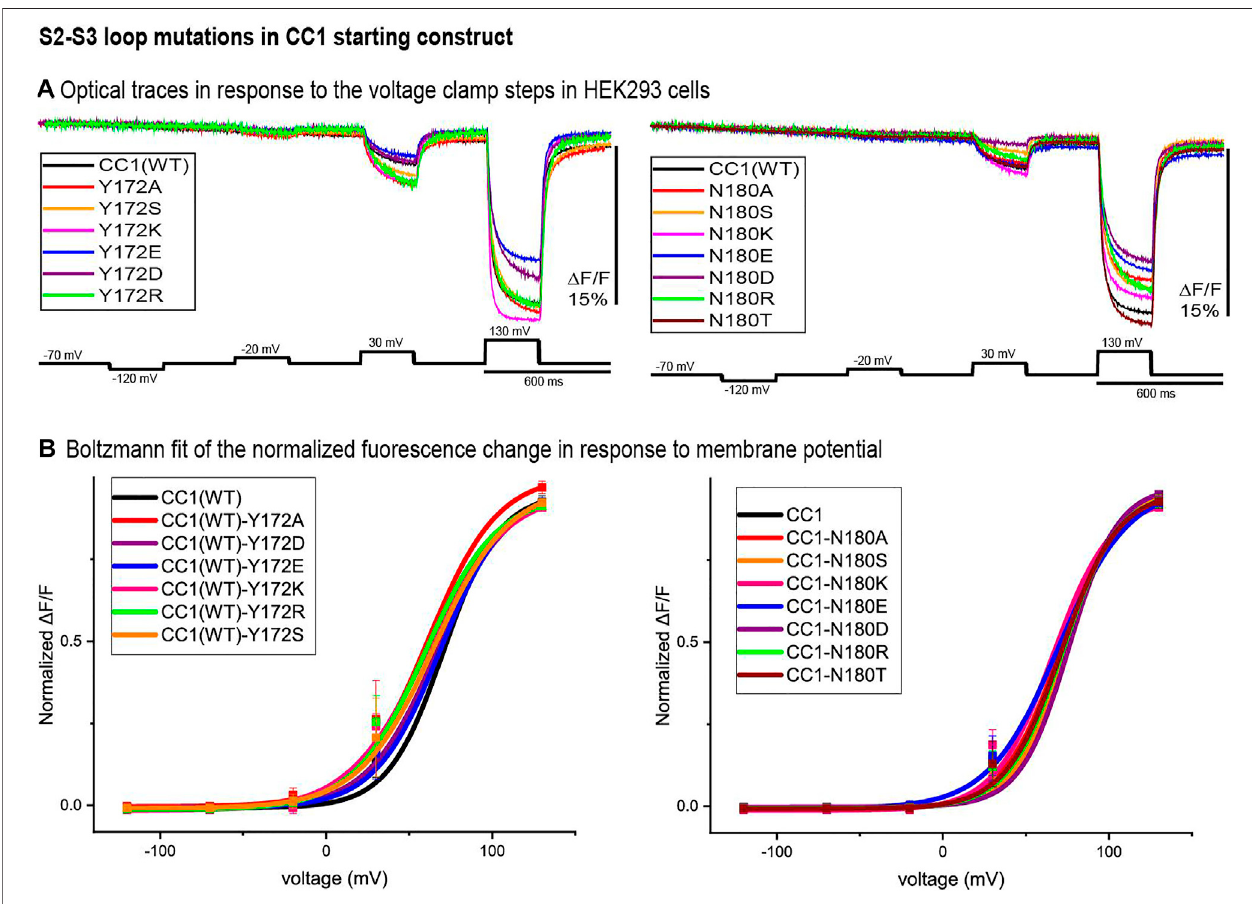
FIGURE 3 | S2-S3 loop mutations in the CC1 starting construct. (A) . Representative fl uorescent traces of HEK cells expressing the CC1(WT) or CC1(WT) with an S2-S3loopmutantinthewholecellpatchclampcon fi guration.Thecellsweresubjectedtothevoltagecommandpulsesinblack.Eachtraceisfromaverageofthreecells and the results from each cell is the average of 16 trials. The traces are fl uorescent optical signals from plasma membrane without temporal fi ltering. Images were recordedataframerateof500fps. (B) .Boltzmann fi tofthenormalized fl uorescencechangefortheCC1constructanditsderivativeprobeswithsinglemutationin the S2-S3 loop ( n = 3 for all